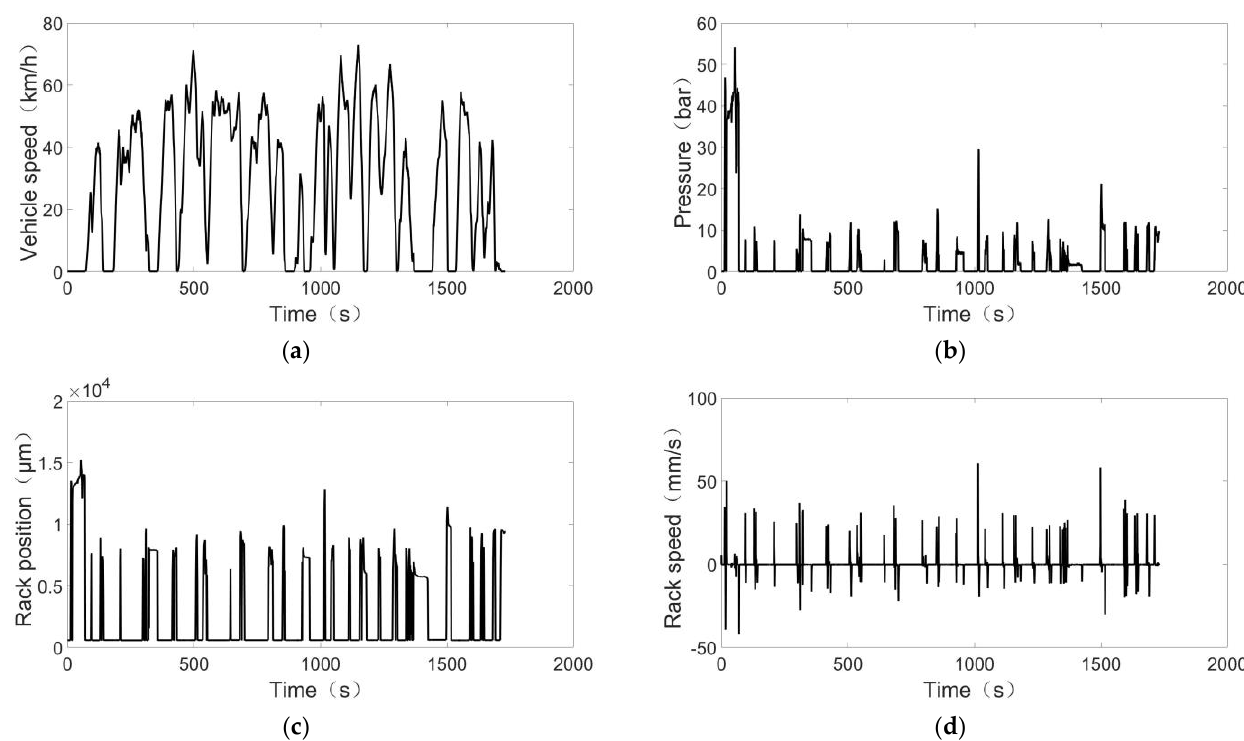
Figure 6. The collected data from the real vehicle test: ( a – d ) denote the vehicle speed, brake pressure, rack position, and rack speed,